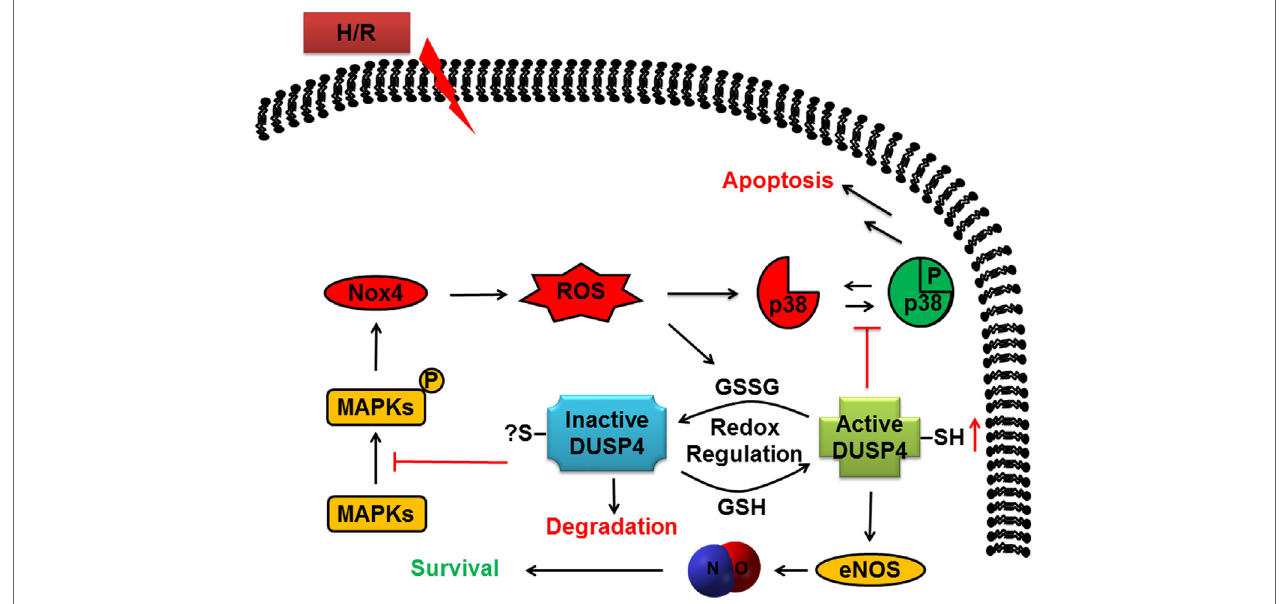
FigUre 6 | The role of dual-specificity phosphatase 4 (DUsP4) in response to h/r-induced oxidant stress to determine cell fate . DUSP4 modulates the activation of mitogen-activated protein kinases in response to H/R injury to influence cellular status toward survival. The cell avoids apoptosis as DUSP4 suppresses uncontrolled activation of p38. Furthermore, DUSP4 overexpression leads to an increase in eNOS expression and stability, which increases cellular NO production to aid the cell in surviving excess reactive oxygen species (ROS). Likewise, overexpression of DUSP4 prompts a decrease in Nox4 expression to cause a subsequent decrease in ROS generation. Overall, DUSP4 acts as an antioxidant gene to provide the cell with multiple mechanisms to protect against H/R-induced oxidant